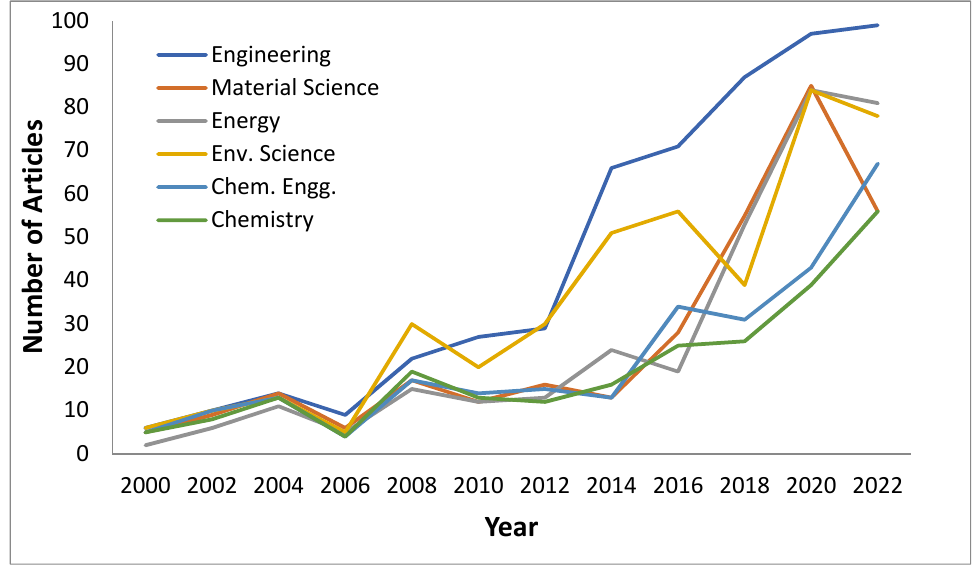
Figure 2. Comparison of research growth trend of the top six productive subject areas. Table 2. The 15 most productive subject areas and published articles.